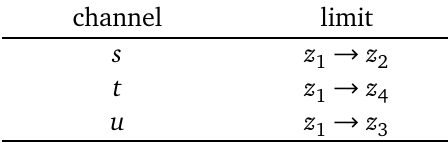
Table 2: The three channels and the corresponding